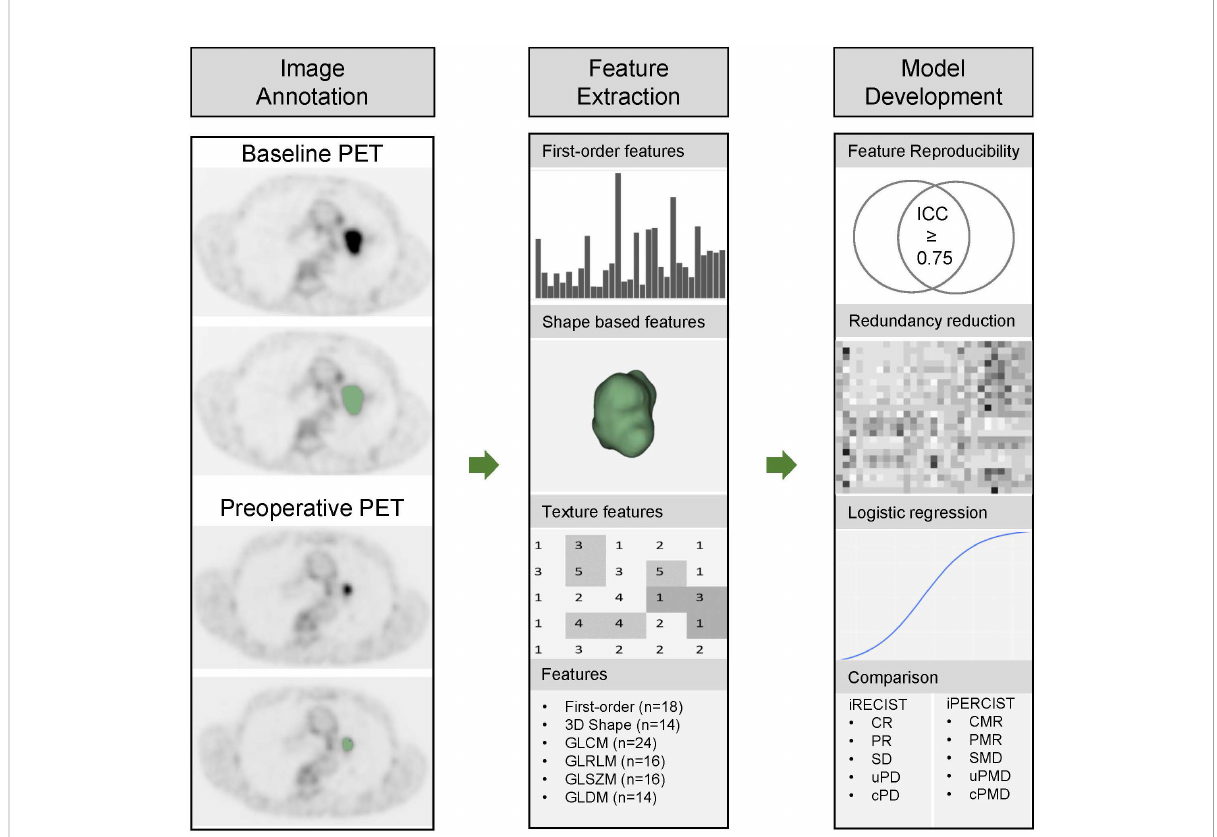
FIGURE 1 Work fl ow for pathological responses prediction and comparison with iRECIST and iPERCIST. The work fl ow includes image annotation, feature extraction, and model development. 3D, three dimension; GLCM, gray level co-occurrence matrix; GLDM, gray level dependence matrix; GLRLM, gray level run length matrix; GLSZM, gray level size zone matrix; ICC, intraclass correlation coef fi